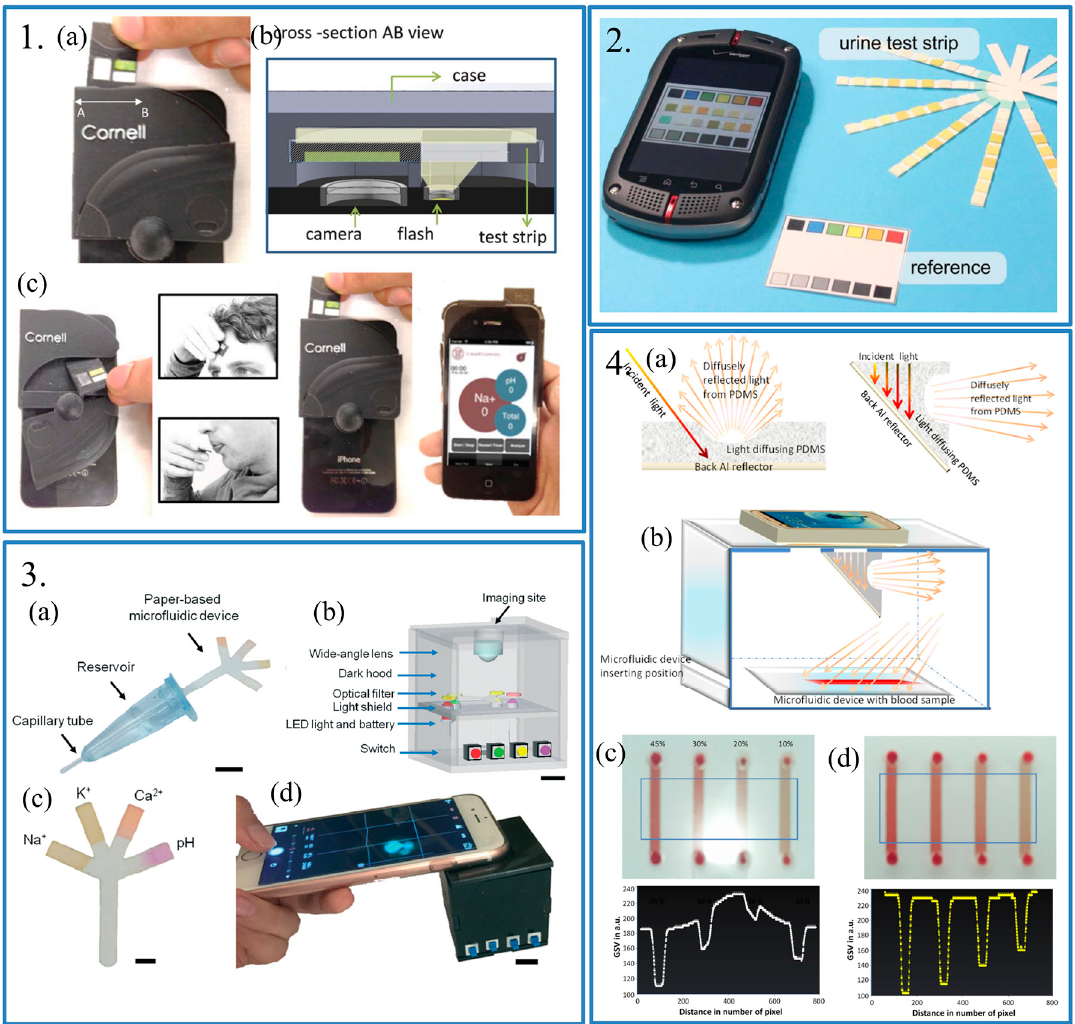
Figure 3. Panel 1: ( a ) Photograph of the test strip and its insertion; ( b ) The cross-section view of the optical system; AB in both ( a ) and ( b ) was the same place; ( c ) Working processing of the smartphone-based health accessory for colorimetric detection of biomarkers in sweat and saliva. From left to right: removing a test strip form the back-storage compartment, acquiring sweat or saliva samples, inserting the test strip in the optical system, analyzing the pH using the APP. Reproduced from [30]. Panel 2: Photograph of the devices for colorimetric detection. A smartphone, a urine test strip and a reference. Reproduced from [31]. Panel 3: ( a ) Schematic of the sample collection and dilution device. Scale bar = 1 cm; ( b ) Schematic of the portable readout device. Scale bar = 1 cm; ( c ) Photograph of the paper-based microfluidic device impregnated with fluorescent probes. Scale bar = 2 mm; ( d ) Photograph of the using of the paper-based microfluidic system for tear electrolyte analysis. Scale bar = 4 mm. Reproduced from [32]. Panel 4: ( a ) Illustrate of the light diffusing effect using a U-shaped PDMS placed on a reflecting aluminum back contact; ( b ) Schematic side view of the smartphone-based optical platform for colorimetric analysis. Images of different hematocrit samples and their grayscale value ( c ) without and ( d ) with PDMS light diffuser. Reproduced from [33].